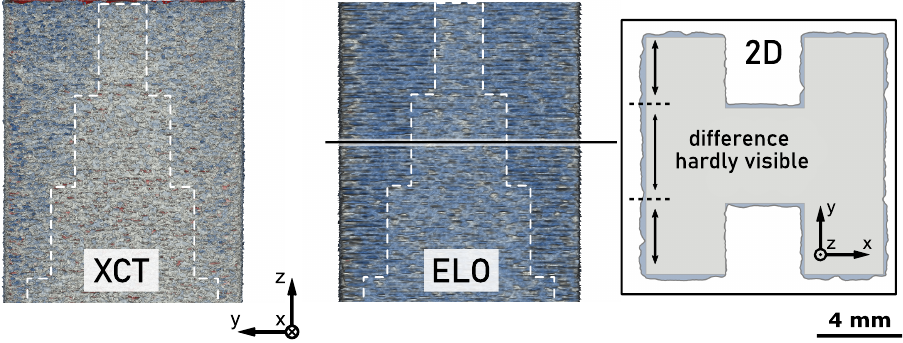
Figure 6. Varying side surface roughness on part A induced by the geometry of the